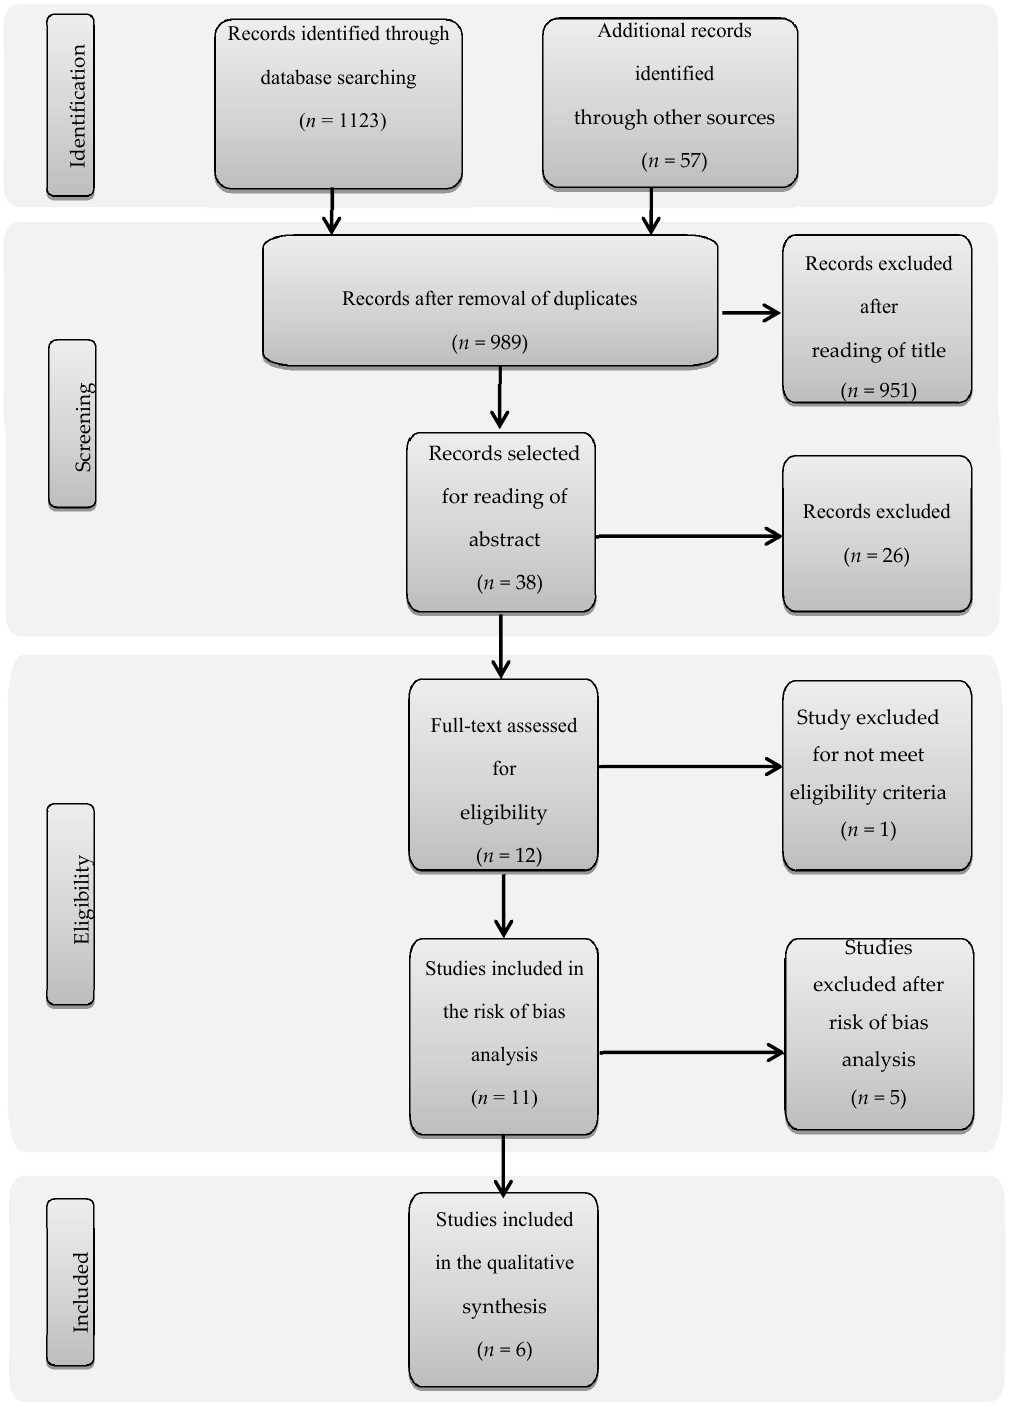
Figure 1. Flowchart of articles selected for the systematic